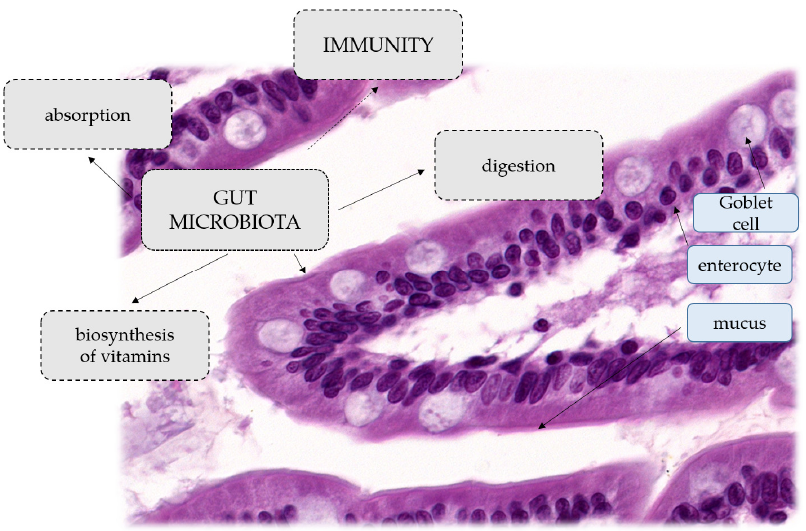
Figure 1. General functions of microbiota. Histological structure of the villus of the small intestine.